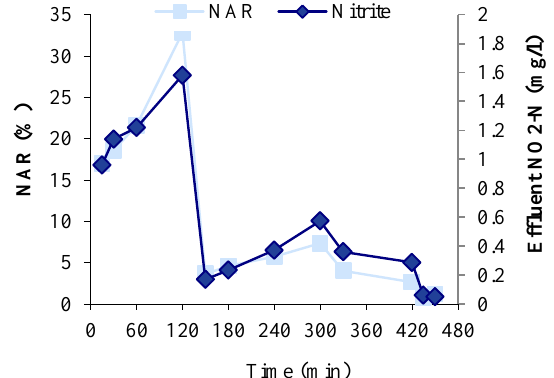
Figure 6. Effect of salinity on the removal percentage of ammonium and chemical oxygen demand (COD) during 62 days of operation (Initial COD concentration = 1000 mg/l, initial ammonium concentration = 50 mg NH With the increasing of salinity up to 3%,